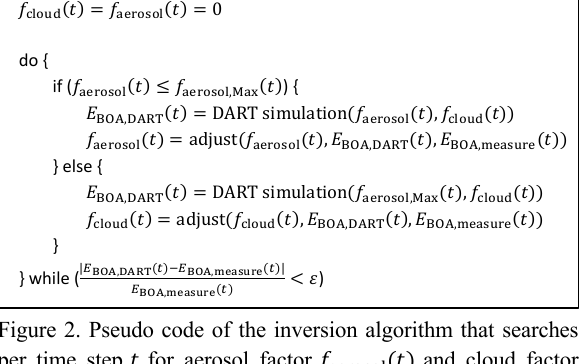
Figure 2. Pseudo code of the inversion algorithm that searches and cloud factor per time step 𝑡 for aerosol factor 𝑓 0/3i1iA (𝑡) 𝑓 @Ai2B (𝑡) such that |l mUV,nVoT (p)ql mUV,Qrstuvr (p)| < 𝜀 , with 𝜀 the l mUV,Qrstuvr (p) relative error